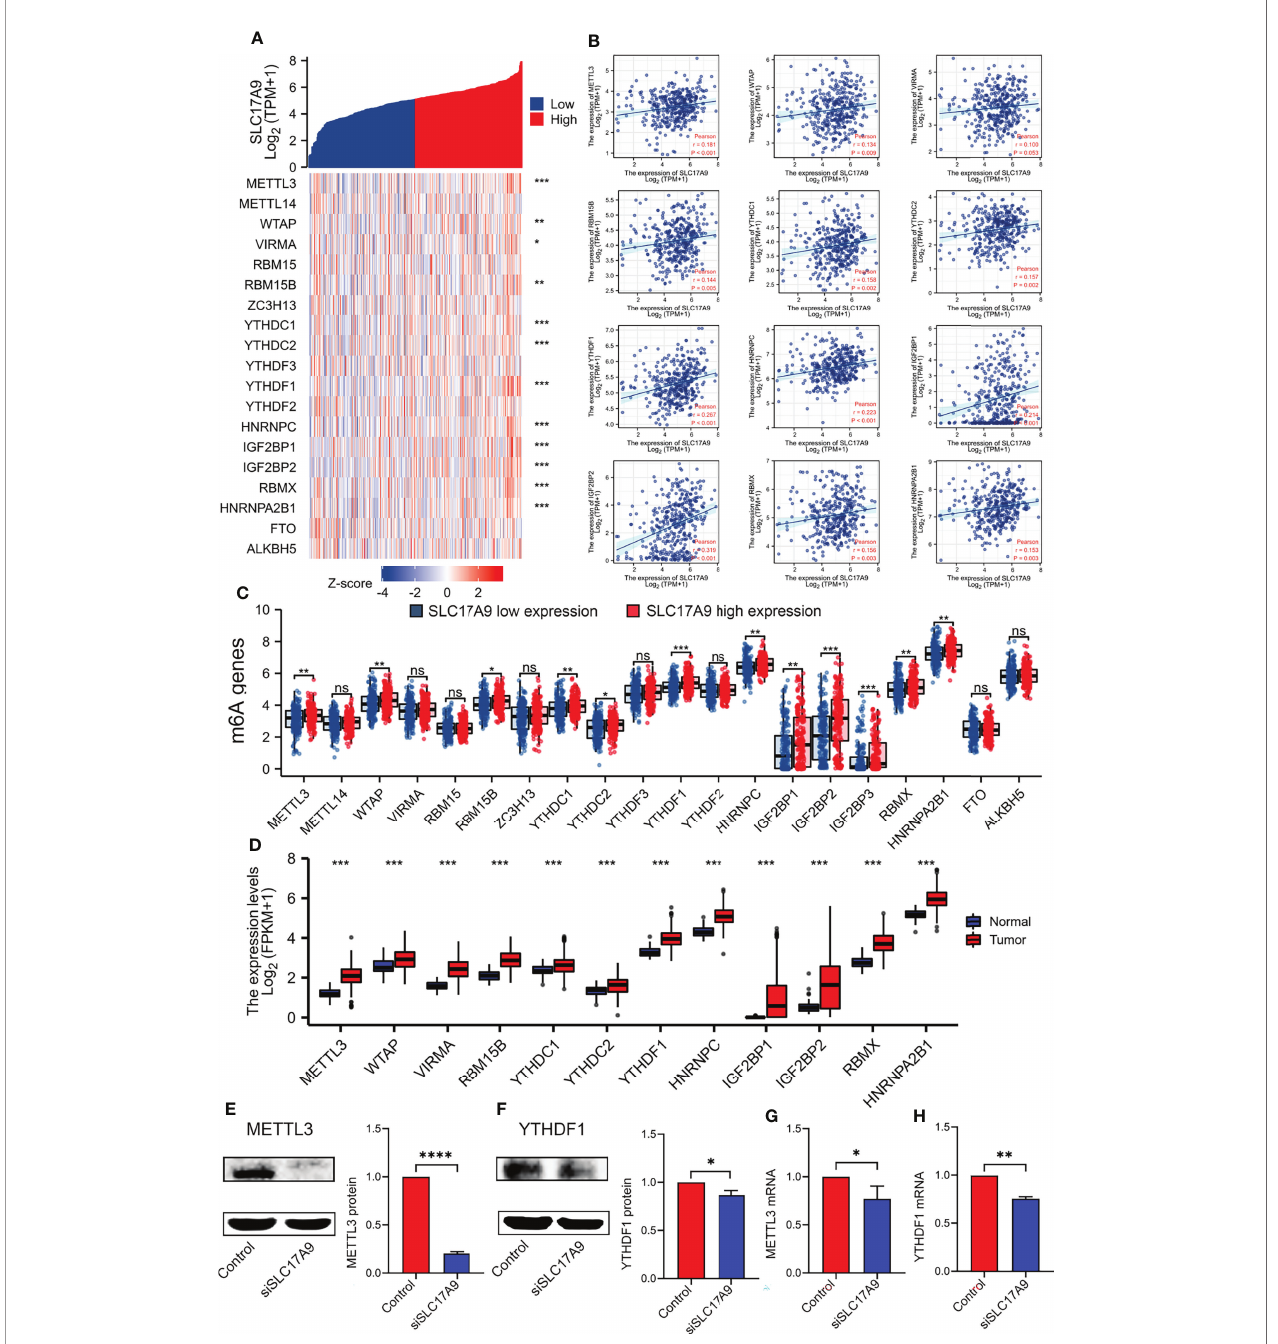
FIGURE 6 | Correlations of SLC17A9 expression with m6A-related genes in LIHC. (A) Thermography shows the correlation between the expression of SLC17A9 and m6A-related genes. (B) The scatter plot shows the correlation between the expression of SLC17A9 and m6A-related genes. (C) Expression of m6A-related genes in the high and low SLC17A9 expression groups in LIHC. (D) m6A regulators expression in tumor and normal tissues. (E, F) METTL3 (left) and YTHDF1 (right) protein expression level in control and siSLC17A9 groups. (G, H) METTL3 (left) and YTHDF1 (right) mRNA expression level in control and siSLC17A9 groups. *p < 0.05; **p < 0.01; ***p < 0.001; ****p <